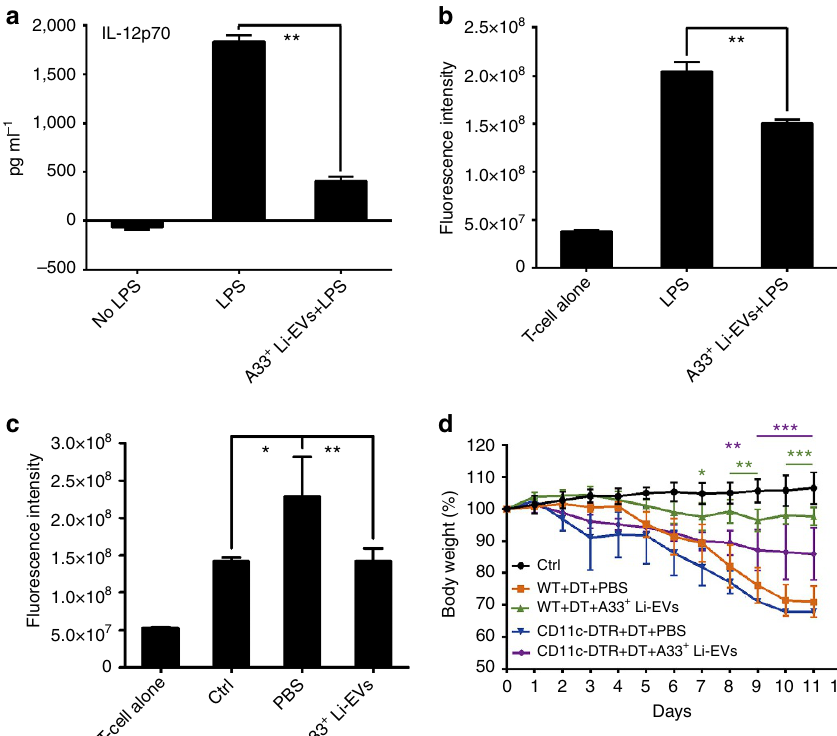
Figure 5 | DCs are involved in alleviating IBD mediated by A33 þ Li-EVs. BMDCs were stimulated with 1 m gml (cid:2) 1 LPS or LPS plus 30 m gml (cid:2) 1 A33 þ Li-EVs for 24h. ( a ) The level of IL-12p70 in the supernatant was measured using enzyme-linked immunosorbent assay (ELISA; n ¼ 9) and ( b ) BMDCs were collected